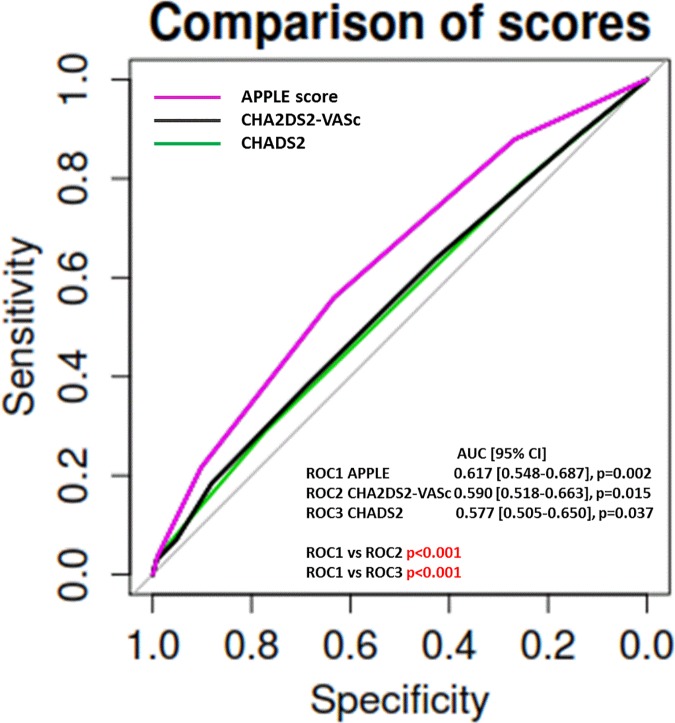
Prediction of arrhythmia recurrences using CHADS2, CHA2DS2-VASc, and APPLE scores.